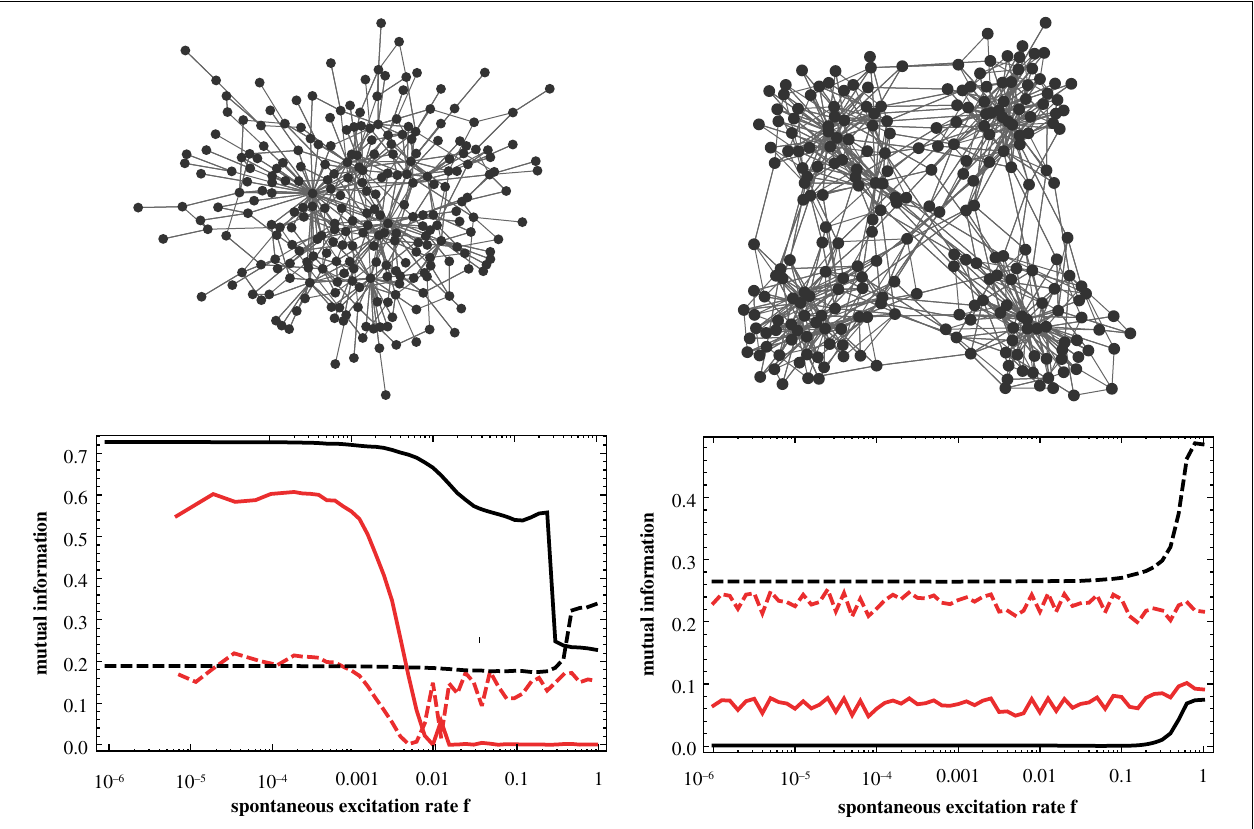
FIGURE 9 | Top row: scalefree (BA) graph (left) and modular graph (right), each consisting of 256 nodes. Bottom row: For each of the graphs, mutual information as a function of f , measuring the correlation of the predicted similarity matrix Q with modularity (matrix T ; dashed curve) and with distance to the ij central node (matrix D ; full curve). In both cases, numerical results are shown as well (red curves) based on a single 5000 time step simulation of the system on